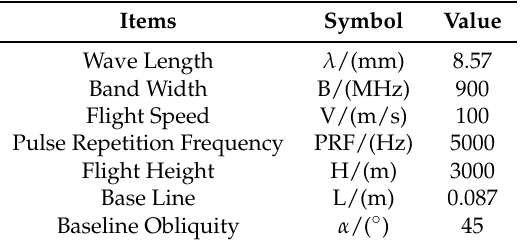
Table 2. Parameters of actual InSAR system.